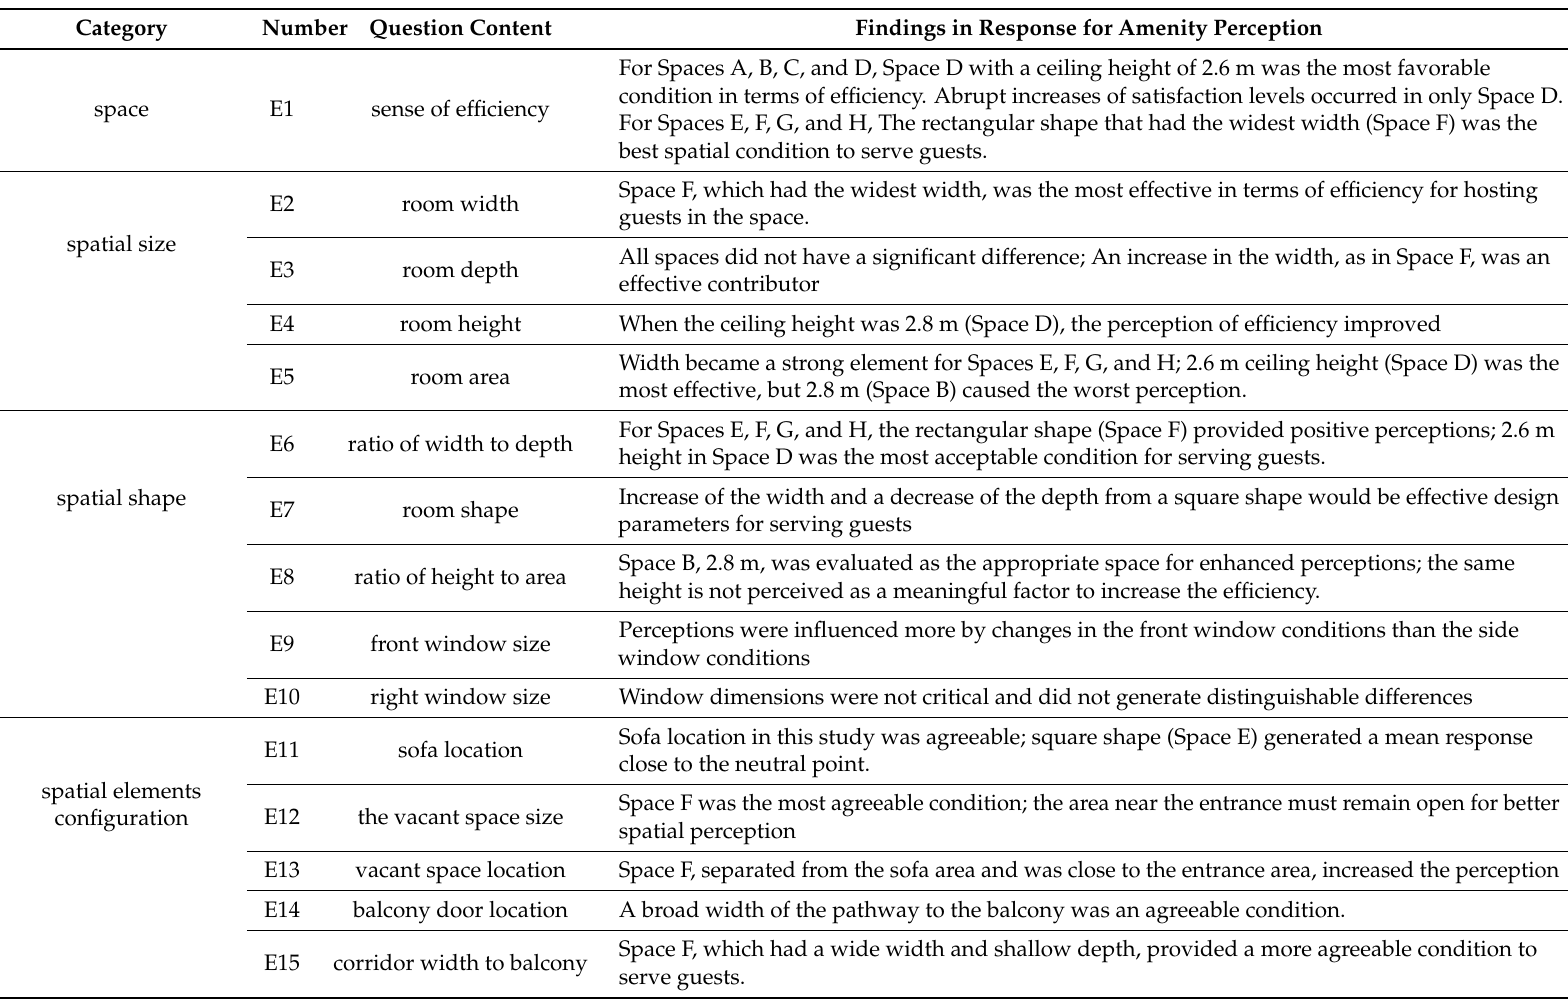
Table 7. Responses for efficiency